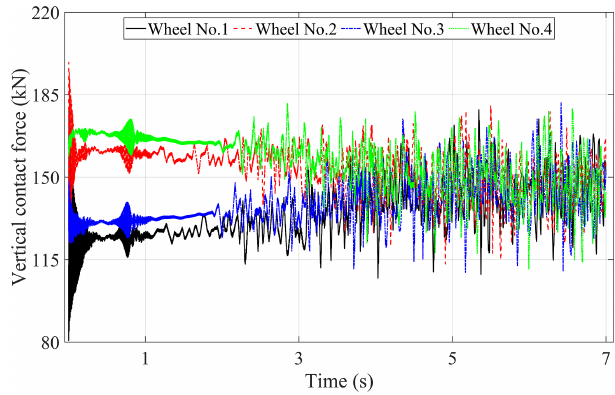
Figure 14. Wheel–rail vertical contact forces under traction condi- tion.